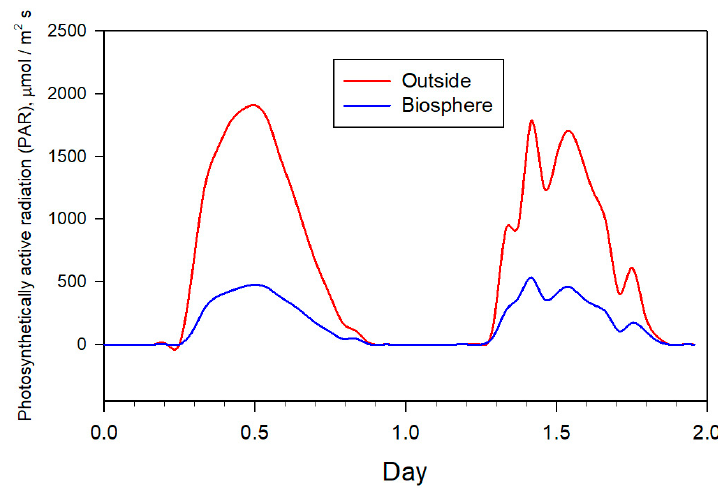
Figure 6. Measured PAR at sea level and the underwater biosphere level.